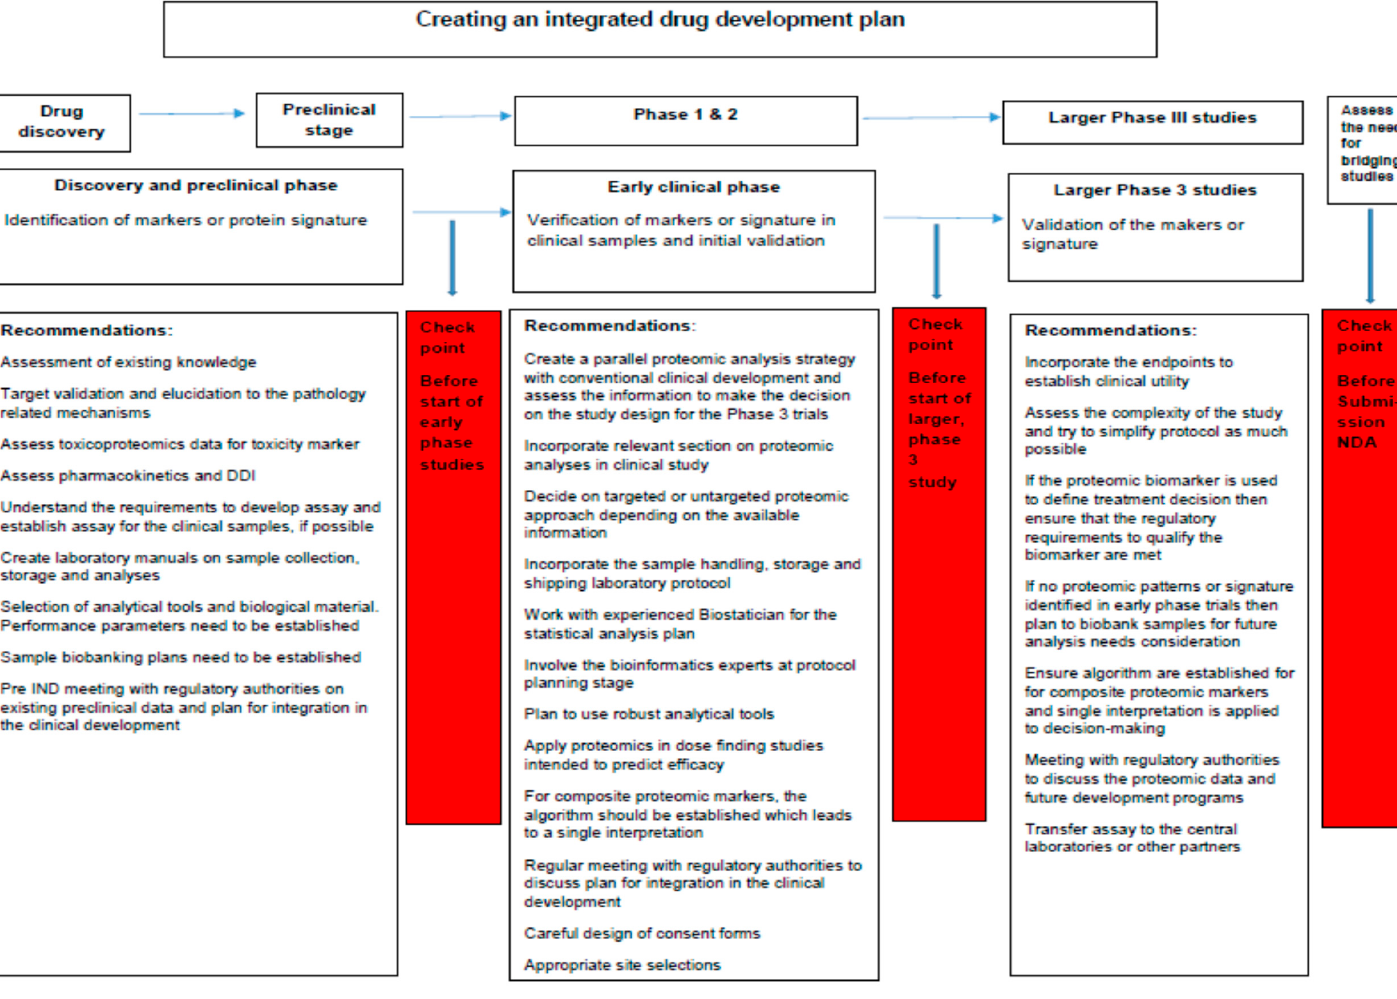
Figure 4. Recommendation on integrating pharmacoproteomic approaches in clinical development plan. The figure illustrates the checkpoints along the conventional clinical research continuum where pharmacoproteomic biomarkers development and application should be assessed.